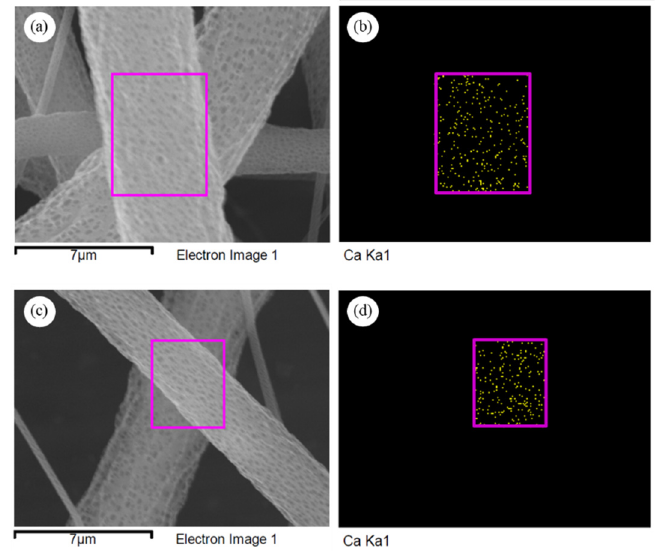
Figure 13. EDS analyzed area and EDS mappings of PLA/1DP − nHAp different applied high voltage ( a , b ) 25 kV and ( c , d ) 30 kV.